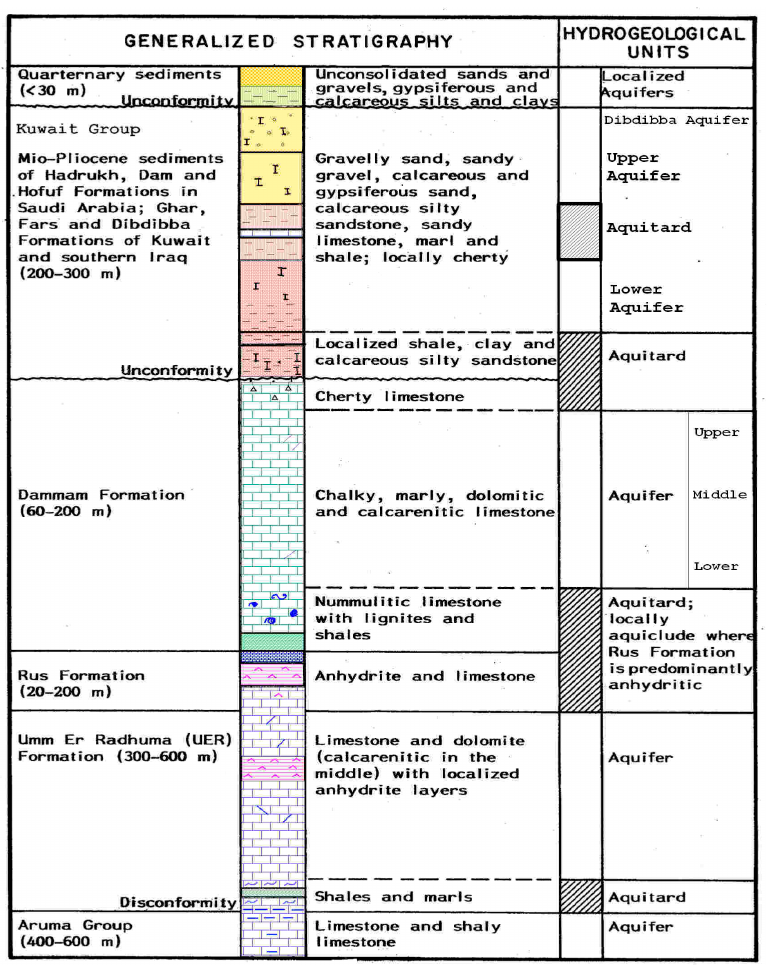
Figure 2. Generalized hydrostratigraphy of the Tertiary deposits in Kuwait and surrounding areas (Source: [16] ).